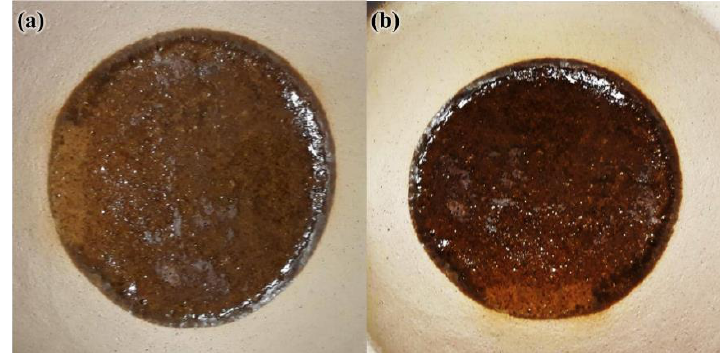
Figure 3. Heated thin ( a ) FAS geopolymer and ( b ) FAB geopolymer at temperature above 1100 °C and 1000 °C, respectively.